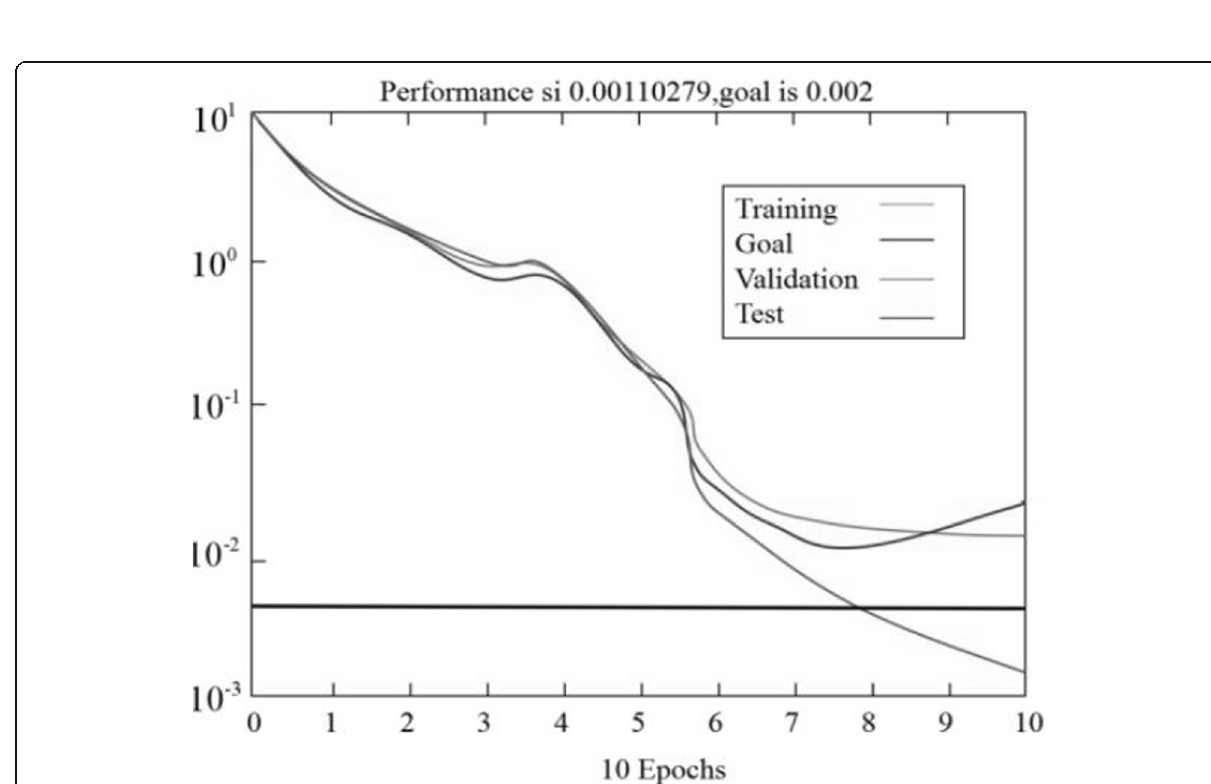
Fig. 7 BP neural network iterative